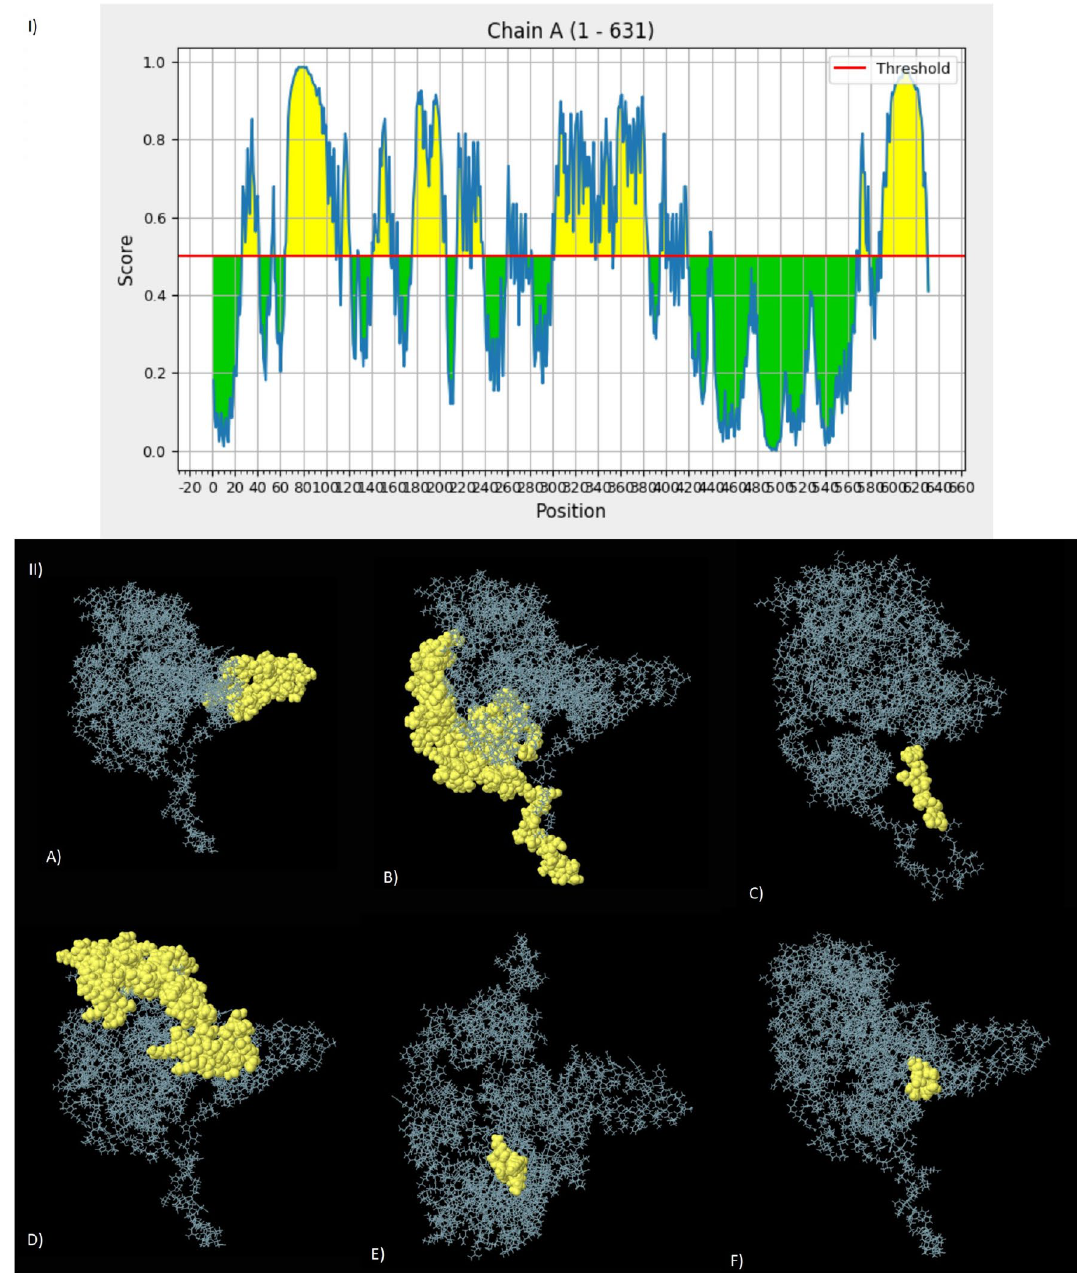
spheres represent the conformational B-cell epitopes. ( A ) 53 residues with a score of 0.809. ( B ) 140 residues with a score of 0.726. ( C ) 10 residues with a score of 0.699. ( D ) 120 residues with a score of 0.681. ( E ) 7 residues with a score of 0.582. ( F ) 5 residues with a score of